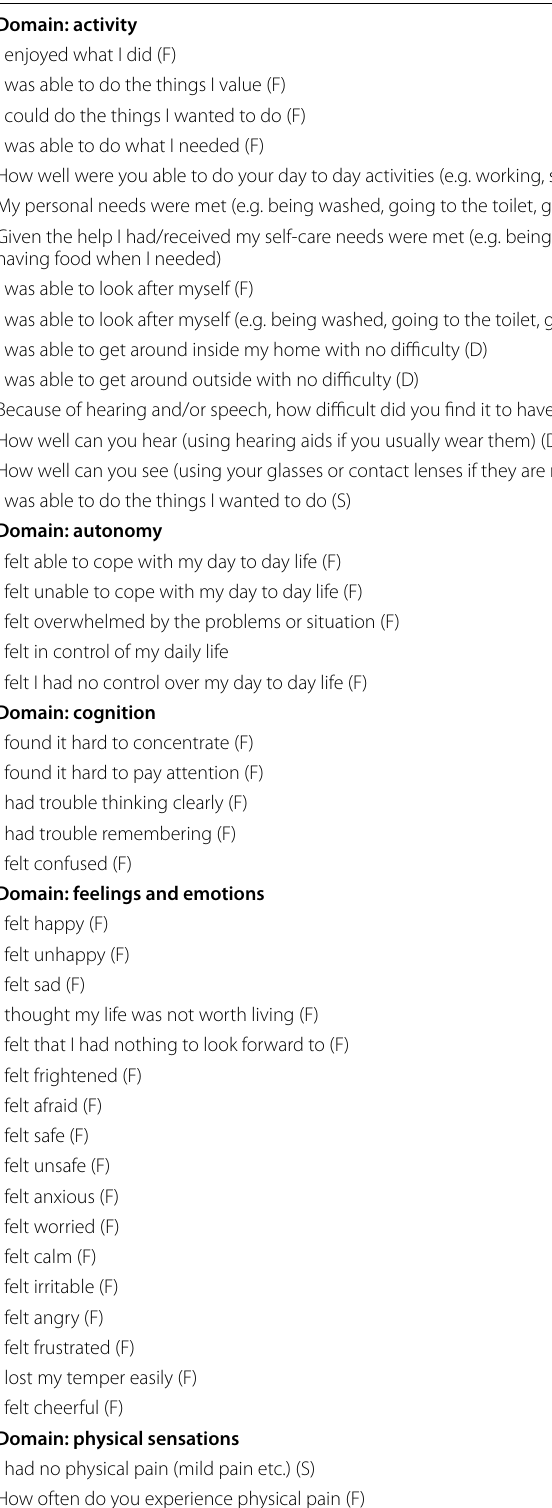
Table 2 Results of PPIE views of draft items for consideration for the EQ-HWB